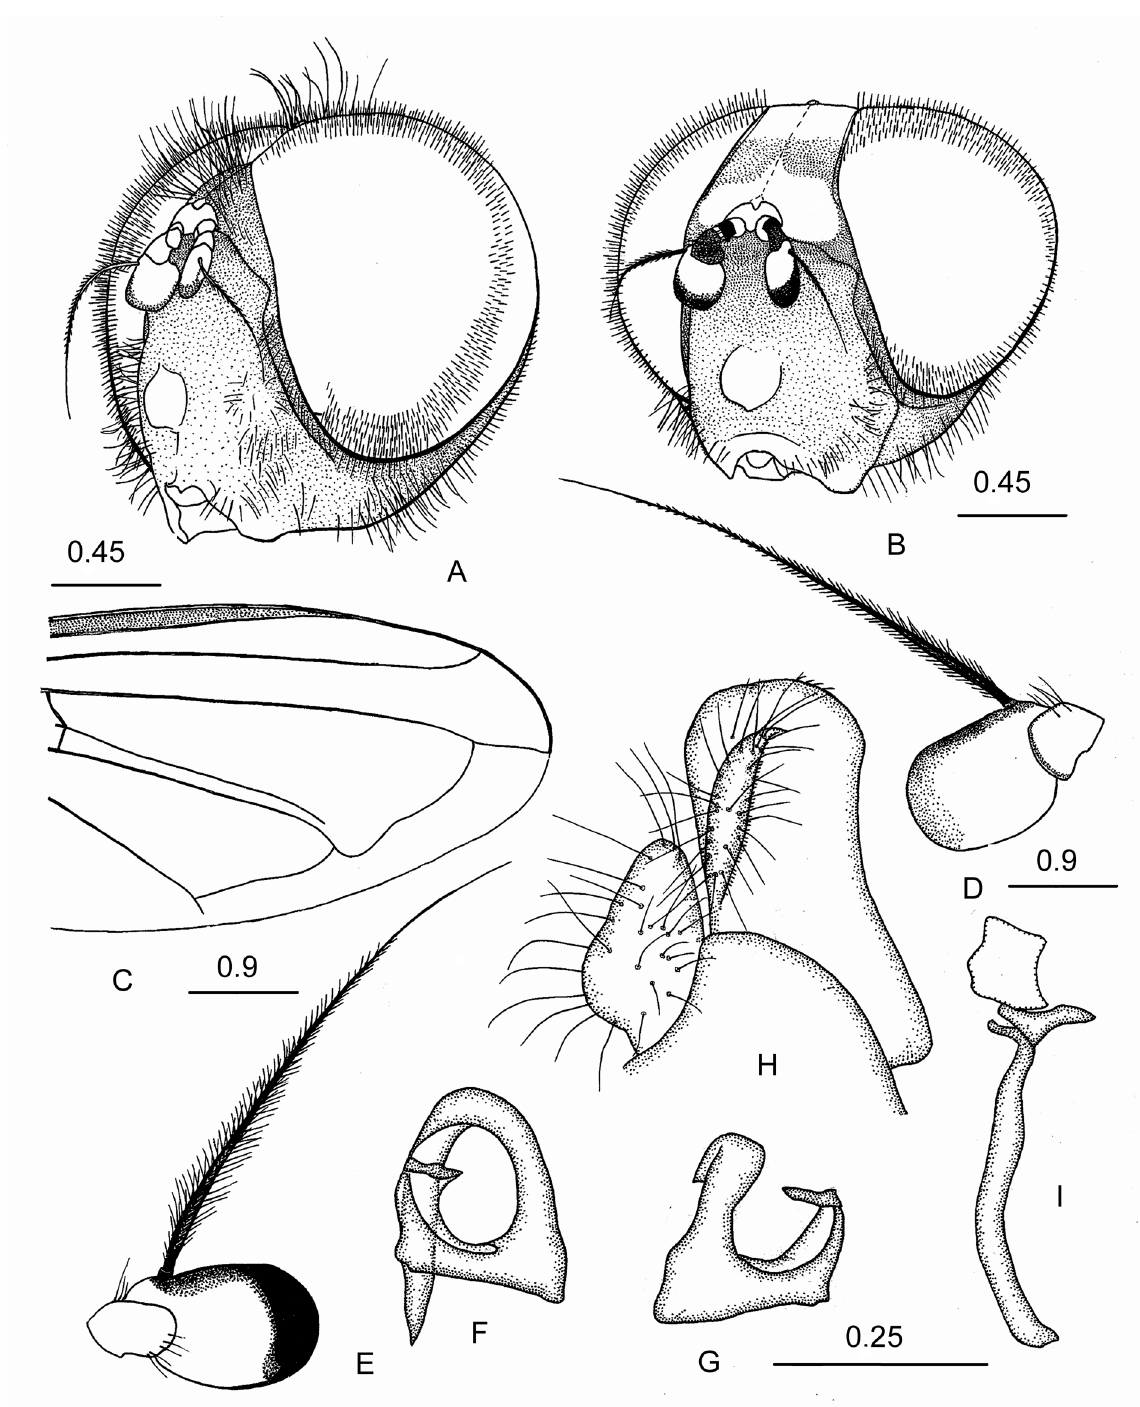
Fig. 56. Cheilosia ( Pollinocheila ) quinta Barkalov & Cheng, 2004. A . Head of ♂, anterior view. B . Same of ♀. C . Tip of wing. D . Antenna of ♂, lateral view of pedicel and basoflagellomere. E . Same of ♀. F– G . Superior lobes of hypandrium, lateral view. H . Surstylus and gonocercus, lateral view. I . Aedeagus and aedeagal apodeme, lateral view. After Barkalov & Cheng 2004. Scale bars indicated in